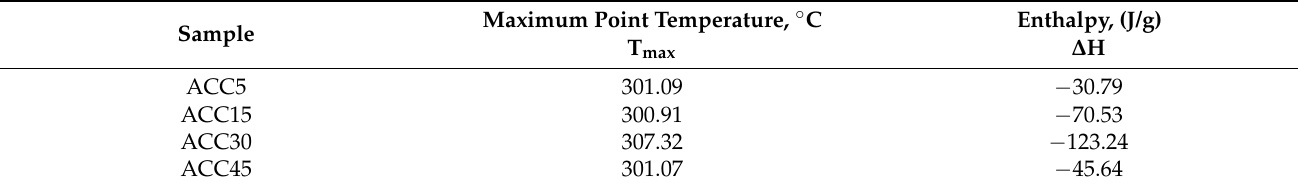
Figure 12. The variations in ( a ) T max and ( b ) ∆H versus dissolution time. Table 6. The variations in (a) T max and (b) ∆H versus dissolution time.